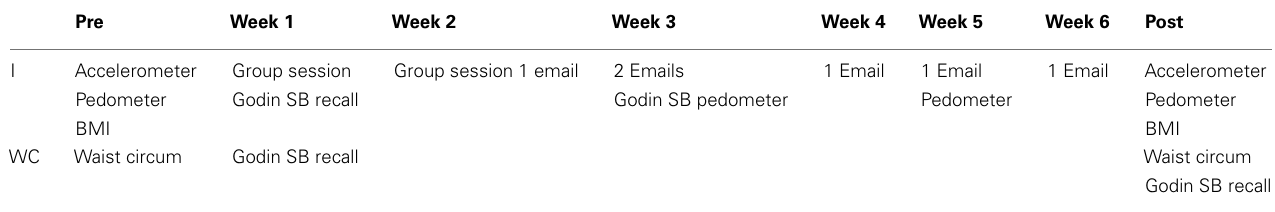
Table 1 | Study contacts and measures.